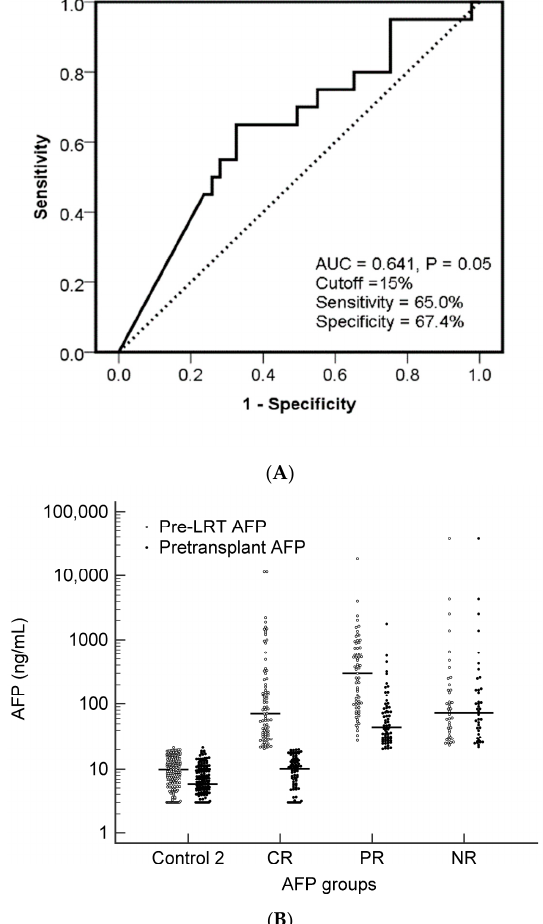
Figure 1. ( A ) Receiver operating characteristic curve analysis of AFP decline in patients with persistent abnormal AFP levels after locoregional therapy (LRT) for predicting tumor recurrence after living donor liver transplantation. ( B ). The distribution of the pre-LRT-maximal and pretransplant AFP levels in four defined groups: control, complete AFP response (CR), partial AFP response (PR), and no AFP response (NR).